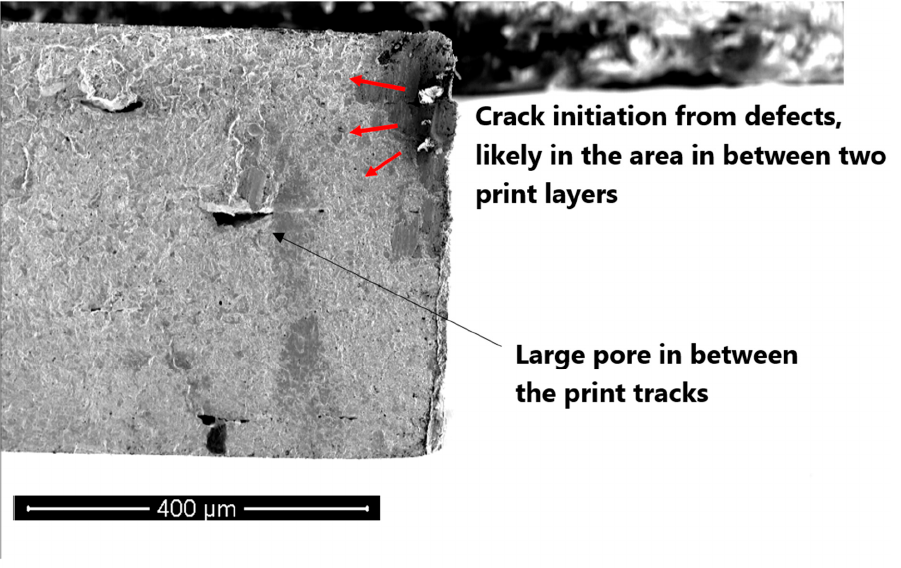
Figure 17. SEM image of the fracture surface of the H fatigue sample. The initiation of crack from sintering defects.